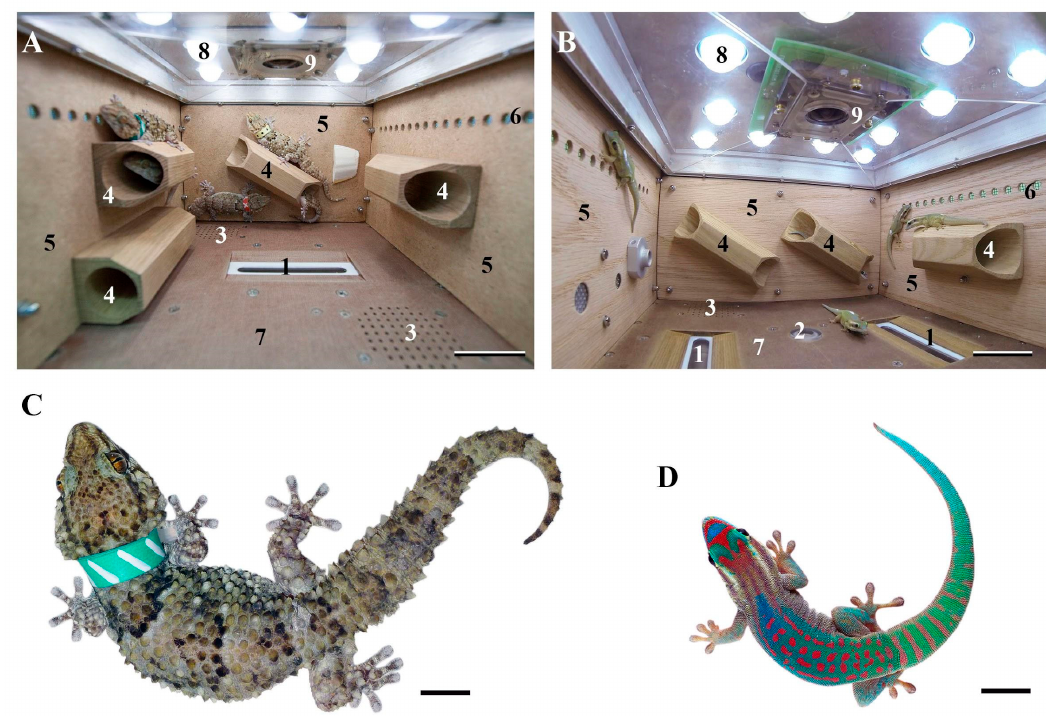
Figure 1. The research and support block (RSB) and geckos used for orbital experiments. ( A ) RSB with thick-toed geckos (Bion-M1 satellite, 30-day spaceflight). ( B ) RSB with ornate day geckos (Foton-M4 satellite, 44,5-day spaceflight). ( C ) Thick-toed gecko female with color marking collar. ( D ) Ornate day gecko male. 1—feedbox; 2—water bowl; 3—heating zones; 4—tubular shelters for geckos made of American oak; 5—RSB walls lined with ( A ) hardboard (a type of fiberboard); ( B ) American oak; 6—vents for ventilation and waste collection; 7—RSB floor made of textile laminate (a fabric reinforced laminate); 8—LEDs; 9—video camera and a fan. Only the RSB for ornate day geckos was equipped with feedbox and water bowl. For a more detailed description of the life support system, see [41]. Bar: ( A ) 5 cm, ( B ) 5 cm, and ( C , D ) 1 cm.